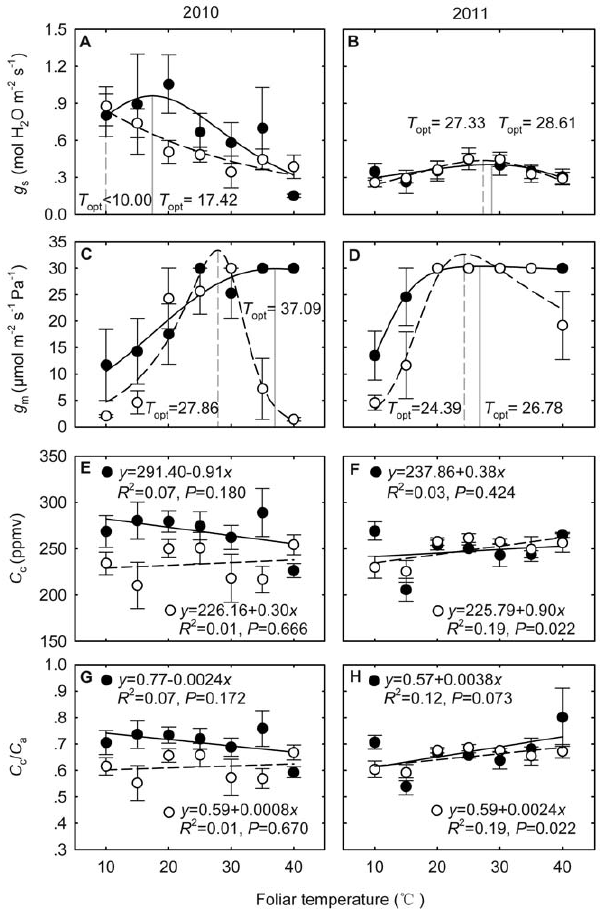
Figure 6. Warming effects on the responses of stomatal conductance ( g s ) (A, B), mesophyll conductance ( g m ) (C, D), carboxylation site CO 2 concentrations ( C c ) (E, F), and C c / C a ratio (G, H) to foliar temperature ( T leaf ) in 2010 (left panels) and 2011 (right panels). The filled circles indicate the warming plots and the open circles for the control plots. Each data point is the average of 4 replicates. Note: g m is constrained to be 30 ( m mol m 2 2 s 2 1 Pa 2 1 ) or less. Table 4. Foliar characteristics of Stipa krylovii Roshev. grown in the control and warming